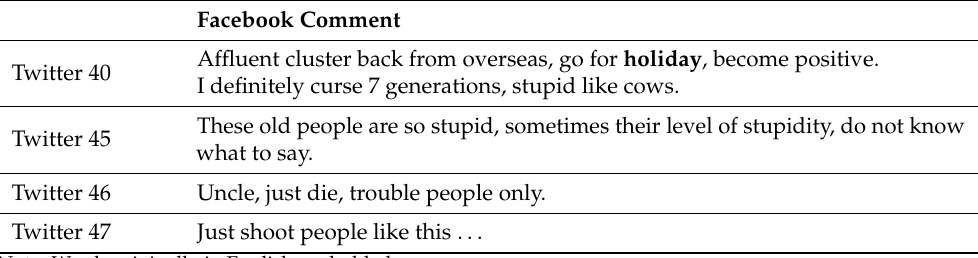
Table 4. Examples of stigmatization of COVID-19 patients from certain social classes in tweets (N = 11). Facebook